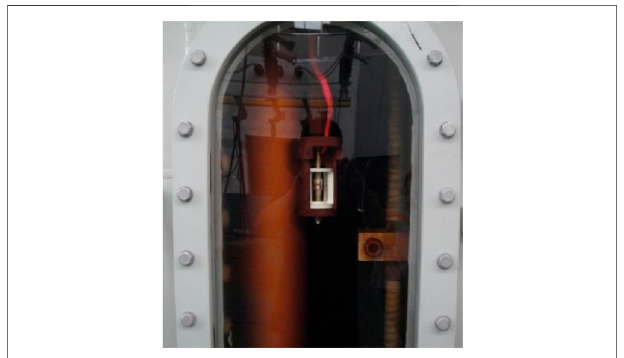
FIGURE 10 | Discharge model in